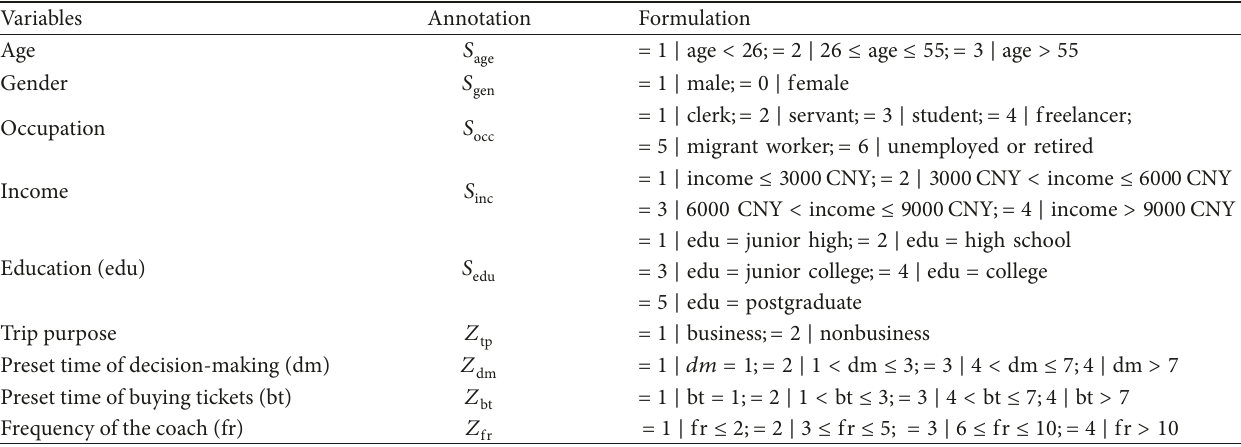
Table 4: Annotations of the observed variables.